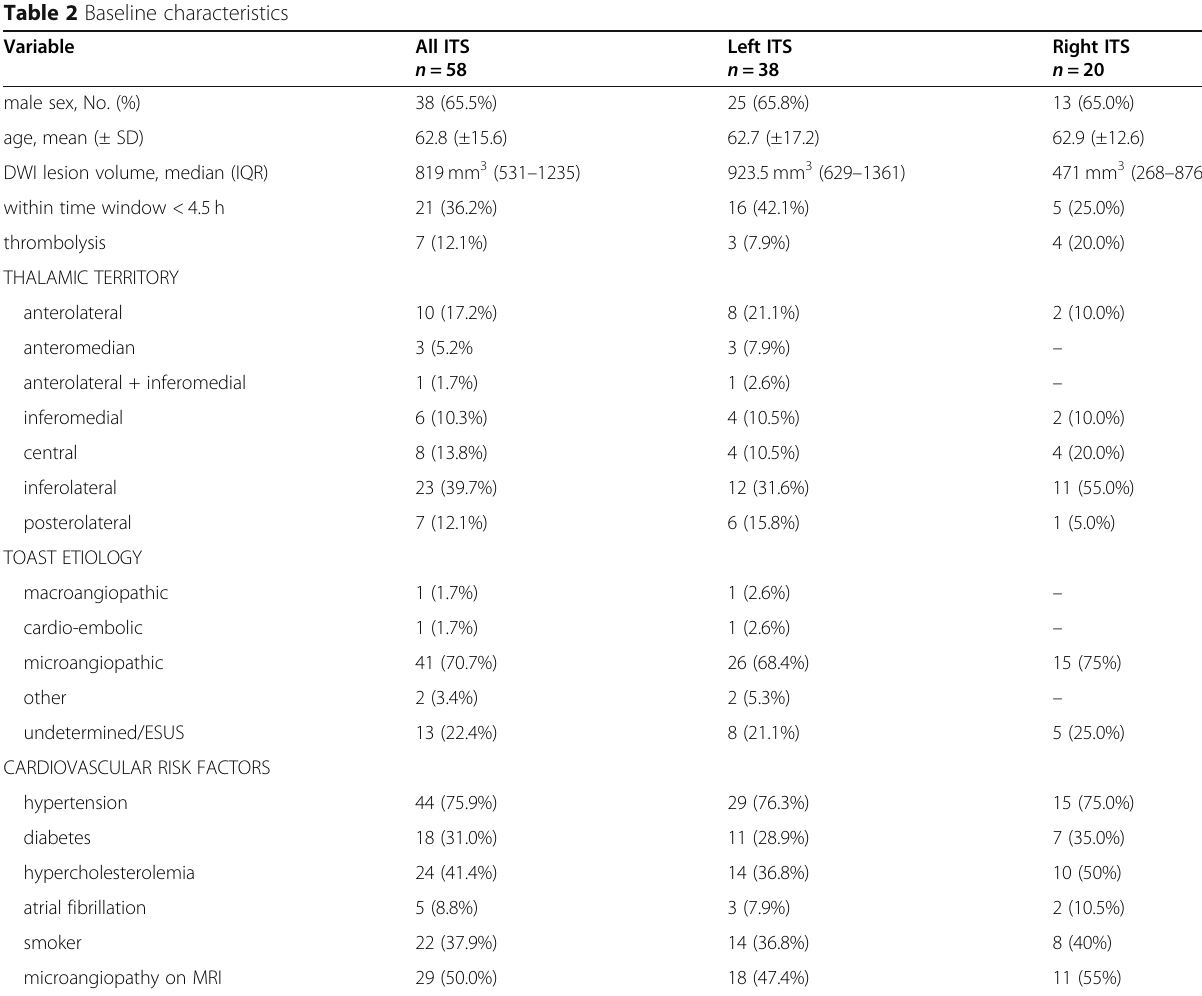
Table 2 Baseline